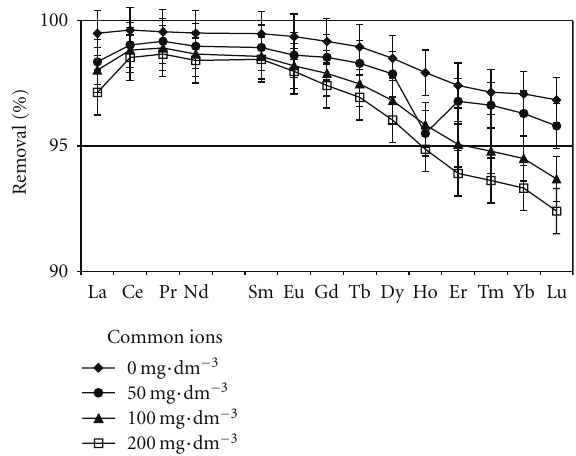
Figure 4: E ff ect of common ions (Ca 2+ , Mg 2+ , Na + , and K + ) on the removal e ffi ciency of lanthanides using ground original